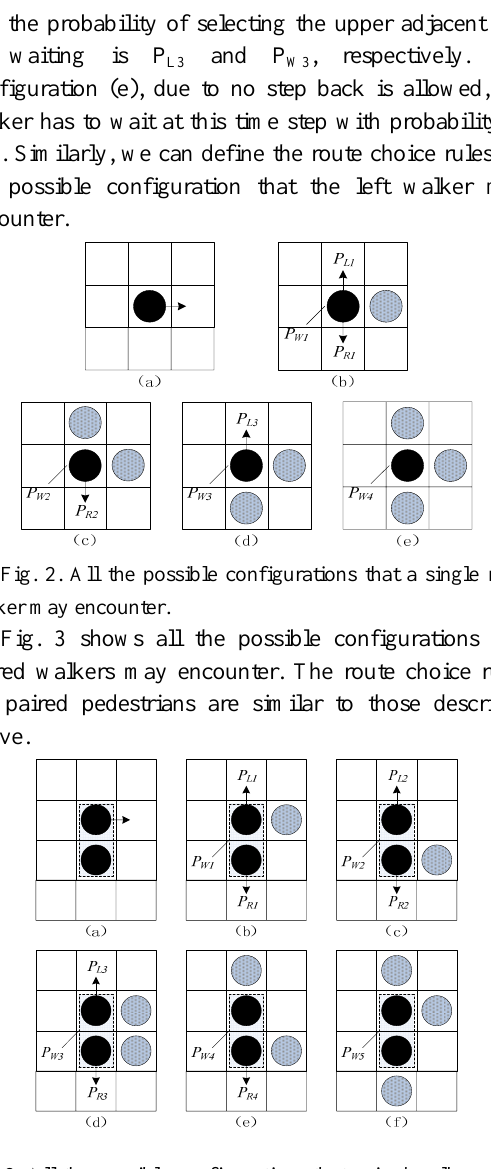
Fig. 3. All the possible configurations that paired walkers may